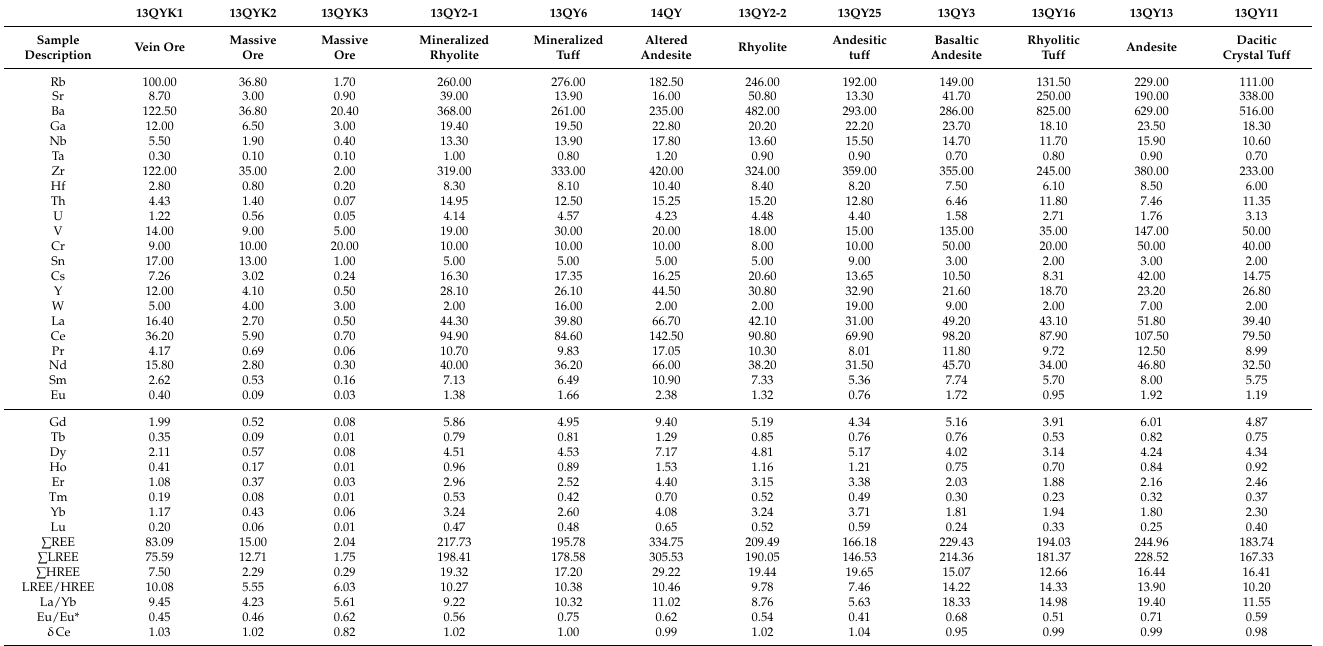
Table 1. Trace element (mg/kg) content of the representative rocks and ores in the Qiyimuchang